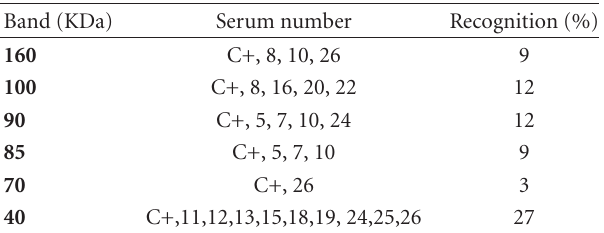
Table 3: Recognition percentages of the di ff erent bands in CE of the T. solium tapeworms by 33 hamster sera infected with T. solium